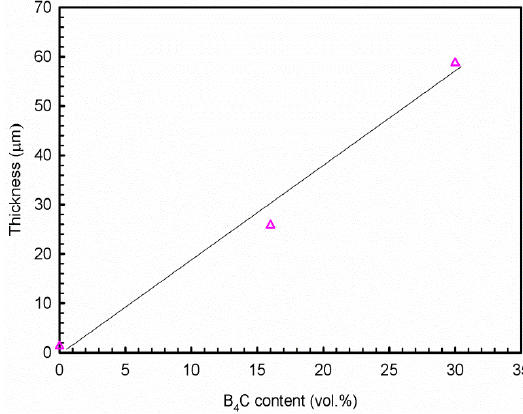
Figure 12. Relationship of corrosion product thickness and B 4 C volume fraction after 10 days exposure in 3.5 wt.% NaCl solution.